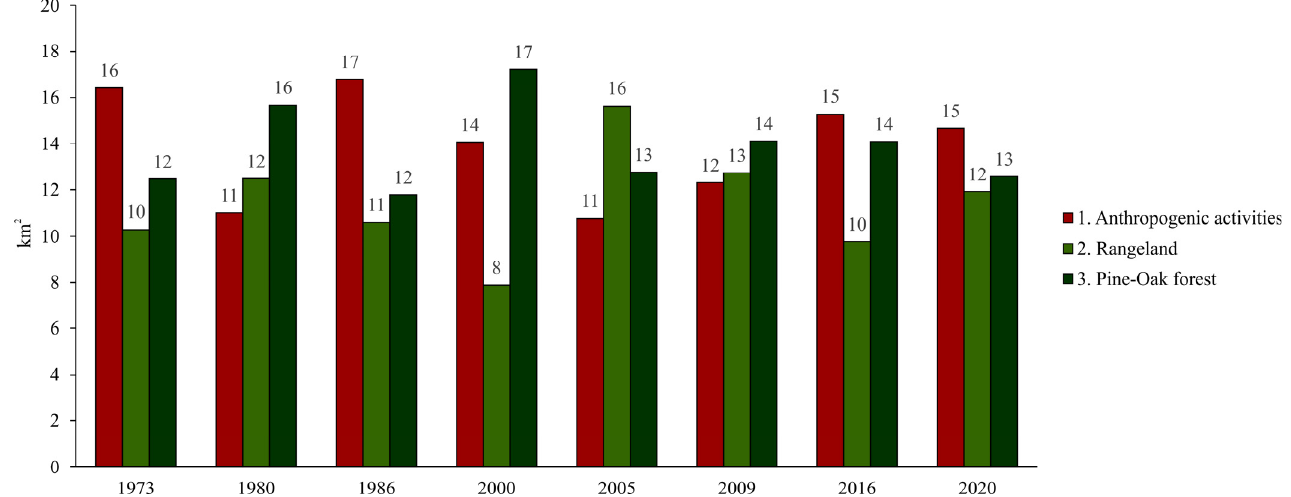
Figure 11. Land use coverage and changes in the study period, La Peña, Miquihuana, Tamaulipas, Mexico.